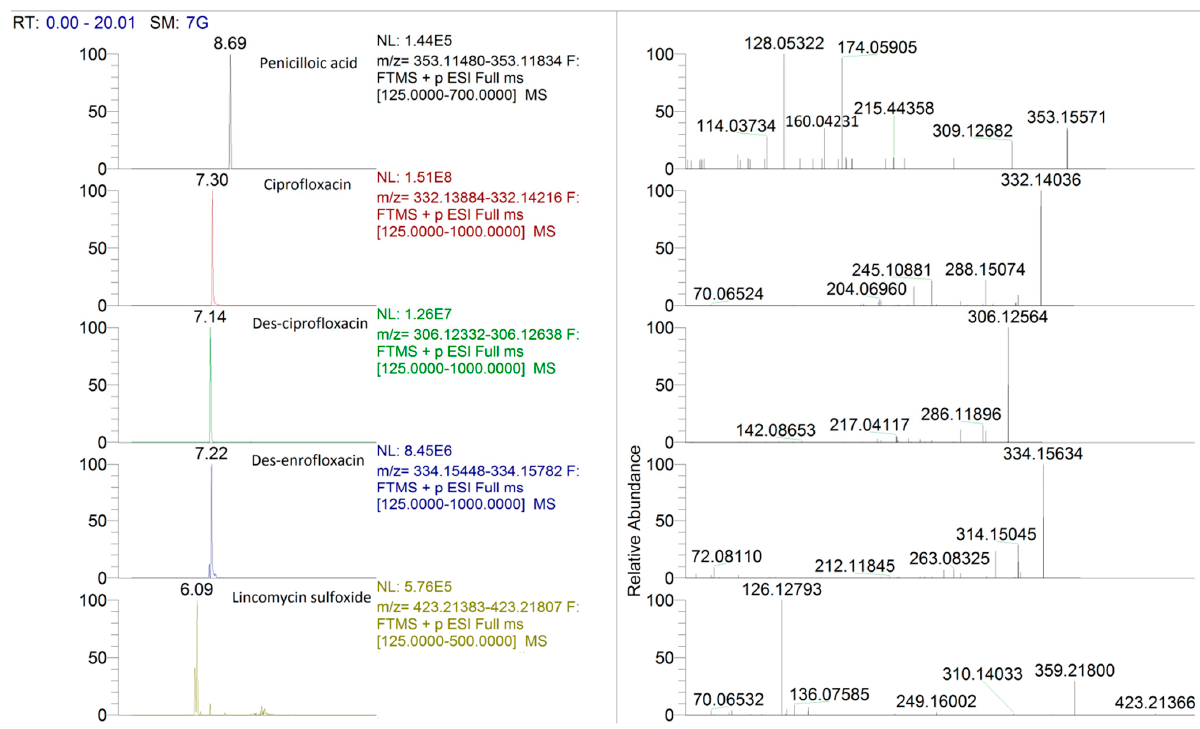
Figure 1. Extracted chromatograms and mass spectra of the metabolites found in our real samples.